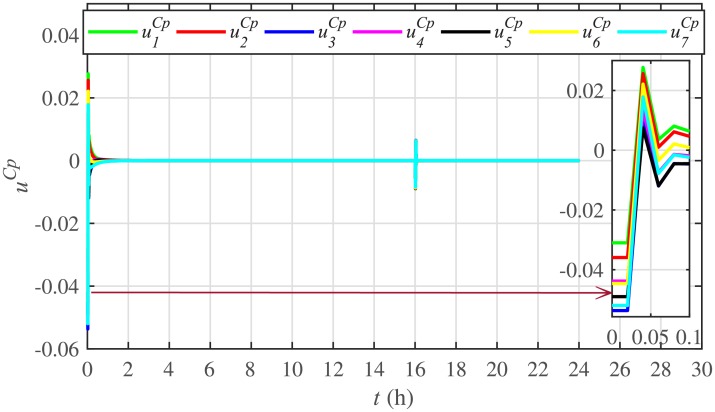
Production costs control efforts under case 1.